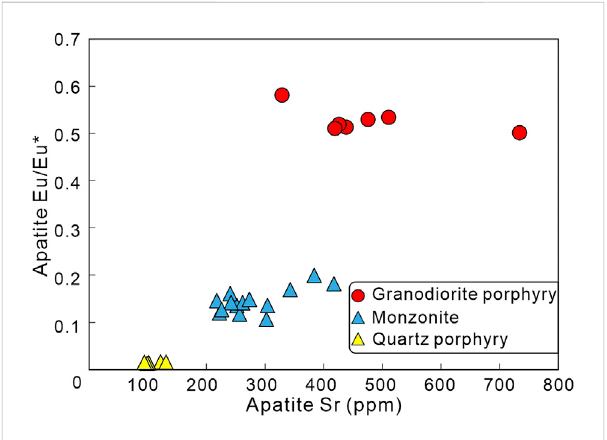
FIGURE 7 Plot of Sr vs . Eu/Eu* in the apatite of the Kalmakyr deposit. There is no positive correlation between the Sr and Eu/Eu* of apatite from the same